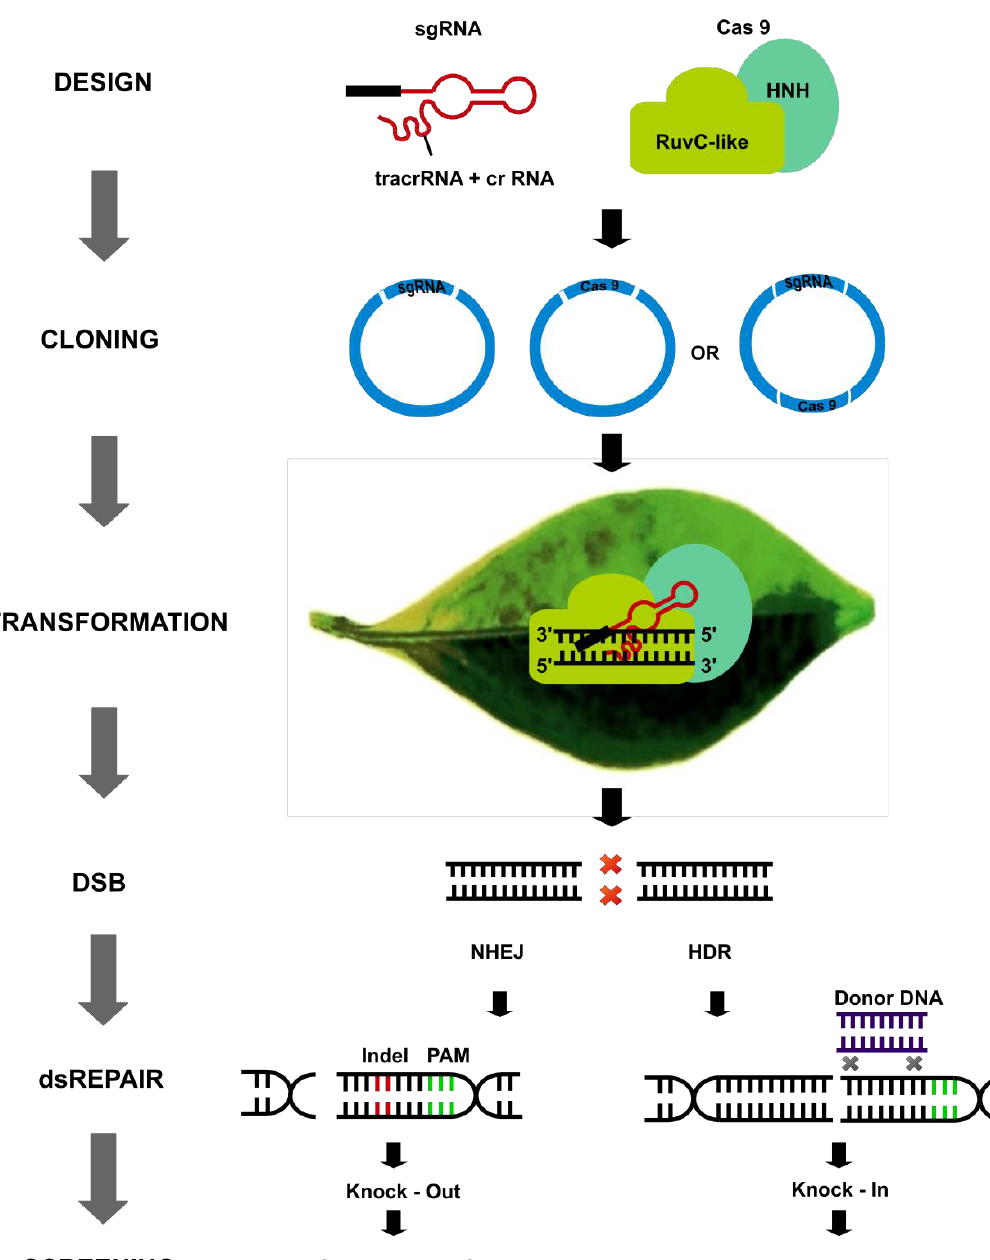
Figure 2. Generalized process for CRISPR / Cas mediated genome editing in plants. sgRNA is composed of a spacer (black), and crRNA and tracrRNA (both shown here in red), and Cas9 is composed of two domains: HNH and RuvC-like domain. HNH domain cleaves the DNA strand complementary to the sgRNA, and RuvC-like domain cleaves the other DNA strand. Cas and sgRNA coding sequences are cloned into a vector (blue), together or individually, which is transformed into the plant cells. The sgRNA and Cas9 are expressed in the plant which then leads to double-strand break (DSB), resulting in activation of DNA repair machinery leading to the modification of DNA sequence and subsequently in the protein coded by sequences and conclusively in the phenotype. The final step is the screening of mutations, which is usually done by PCR and sequencing. Abbreviations: Cas9: CRISPR associated protein 9; crRNA: CRISPR RNA; DSB: double-stranded break; dsREPAIR: double-strand repair; HDR: homology directed repair; Indel: insertion or deletion mutations; NHEJ: non-homologous end joining; sgRNA: single guide RNA; tracrRNA: transactivating CRISPR RNA.